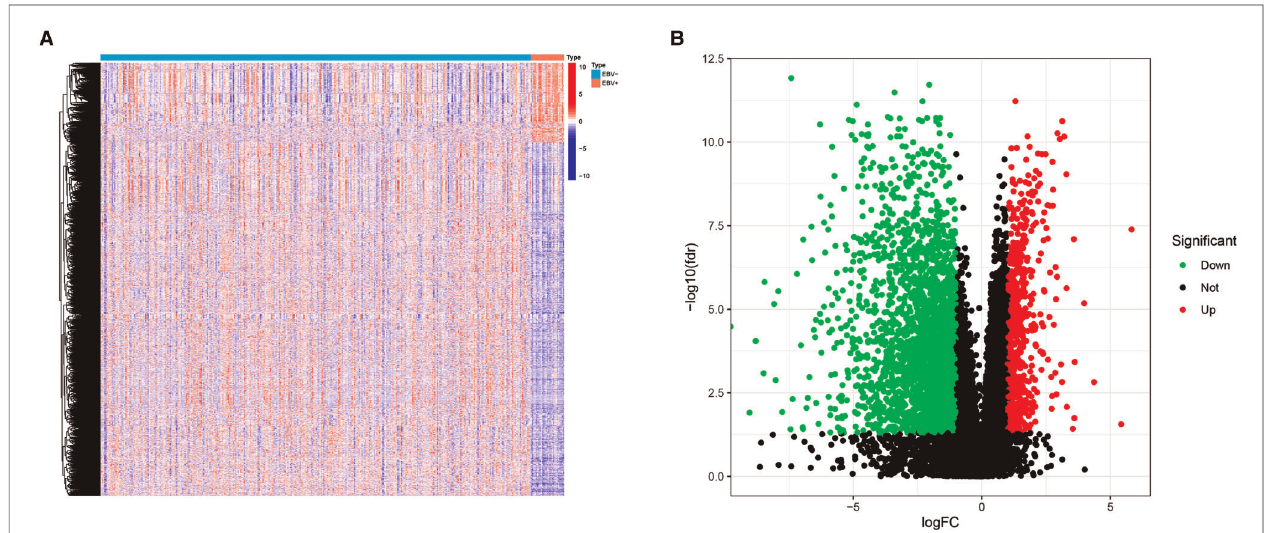
FIGURE 2 | DEGs. ( A ) Heatmap for DEGs between EBVaGC(EBV+) and EBVnGC(EBV − ). ( B ) Volcano plot of DEGs between EBVaGC and